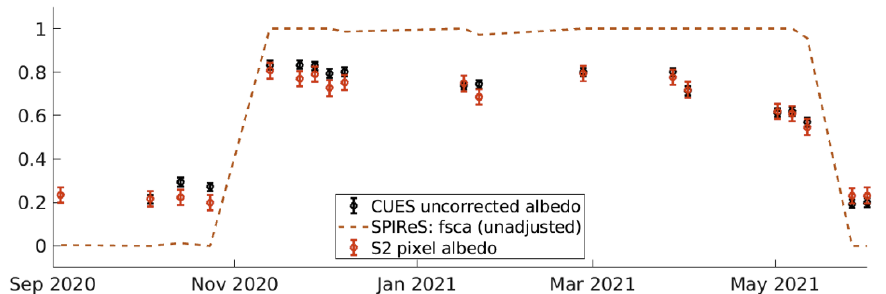
Figure 7. In situ and remotely sensed snow on Mammoth Mountain, water year 2021. Shown are uncorrected albedos measured at CUES, with the error bars (0.020) based on stated values from the manufacturer. The unadjusted (i.e., not adjusted for shade or trees) fractional snow-covered area ( f sca ) from the Snow Property Inversion from Remote Sensing (SPIReS) model is shown. An estimate of the broadband pixel albedo measured by Sentinel 2A/B (S2) is shown. The error bar height (0.036) is the maximum difference in the bare-ground (no snow)